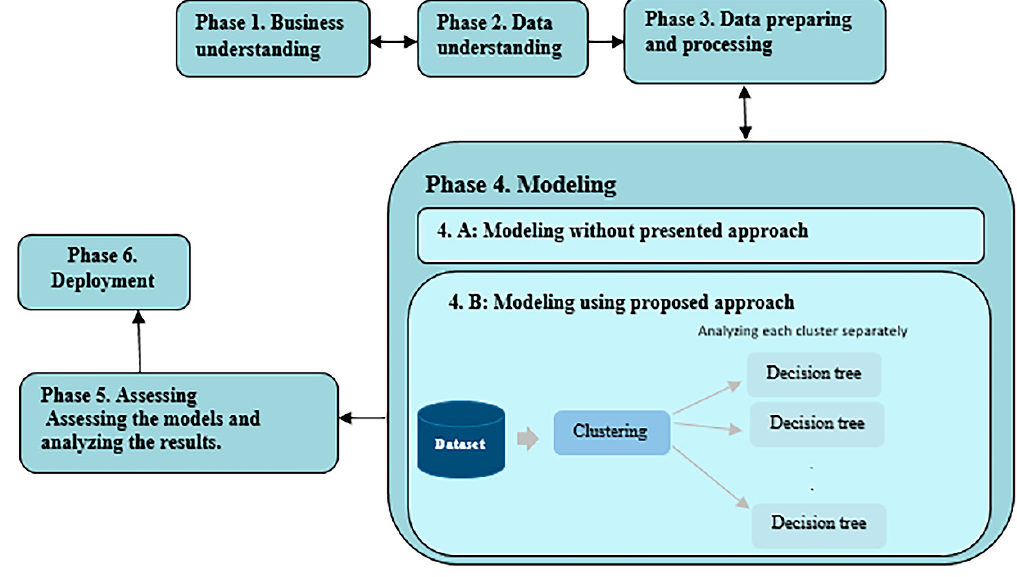
Figure 1. The methodology used—an overview.